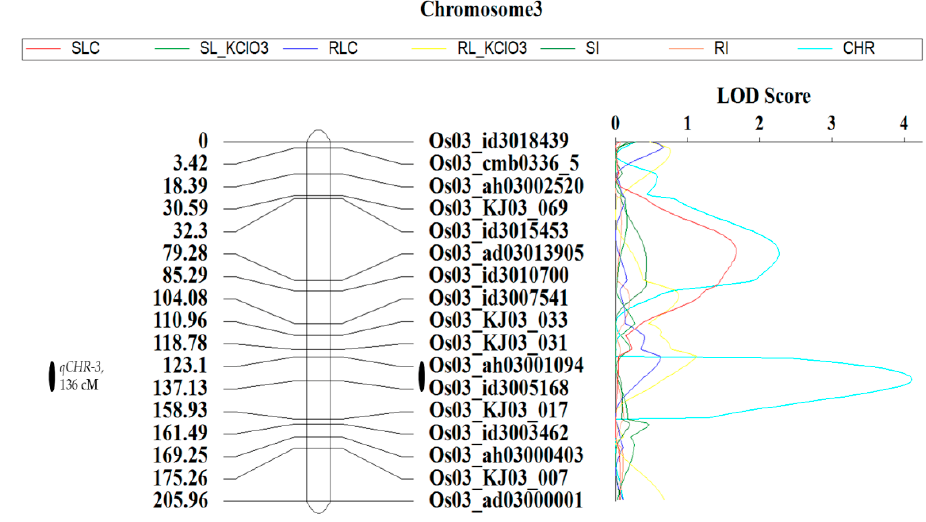
Figure 5. Linkage map and identified QTL associated with chlorate resistance in rice. The significant QTL for chlorate resistance was detected on chromosome 3 (136 cM) in rice. KASP markers associated with the QTL qCHR-3 with logarithm of the odds (LOD) above the threshold set at 3 were Os03_ah03001094 (left, 126.5 cM) and Os03_id3005168 (right, 146.5). Left side of the linkage map shows the position of the mapped KASP markers in cM (right side). The LOD profile is displayed on the right side of the linkage map. SLC, shoot length with no treatment; SL_KClO3, shoot length with treatment; RLC, root length without treatment; RL_KClO3, root length after treatment; SI, shoot inhibition percentage; RI, root inhibition percentage; and CHR, chlorate resistance in